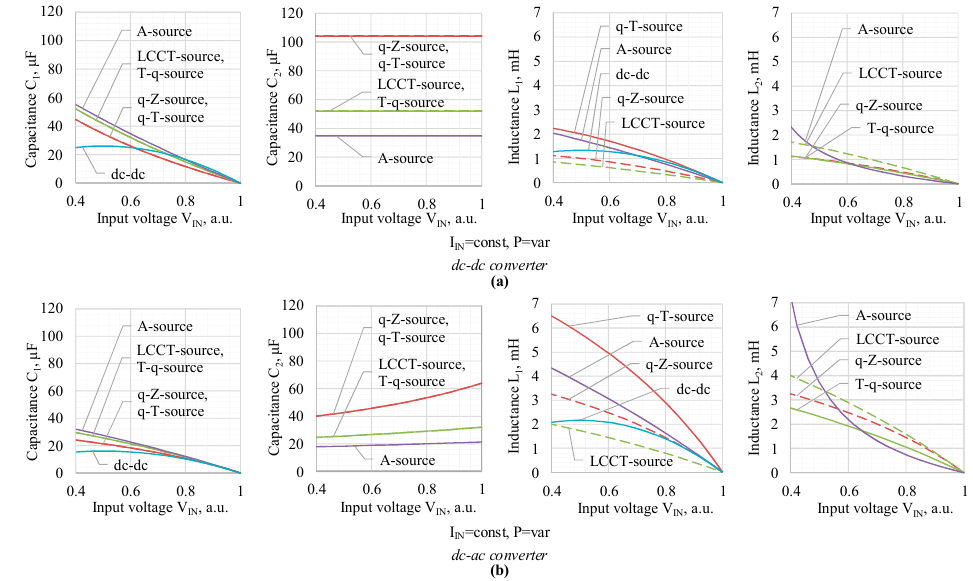
Figure 4. Value of the passive components as a function of the input voltage for ( a ) the dc ‐ dc and ( b ) the dc ‐ ac application.